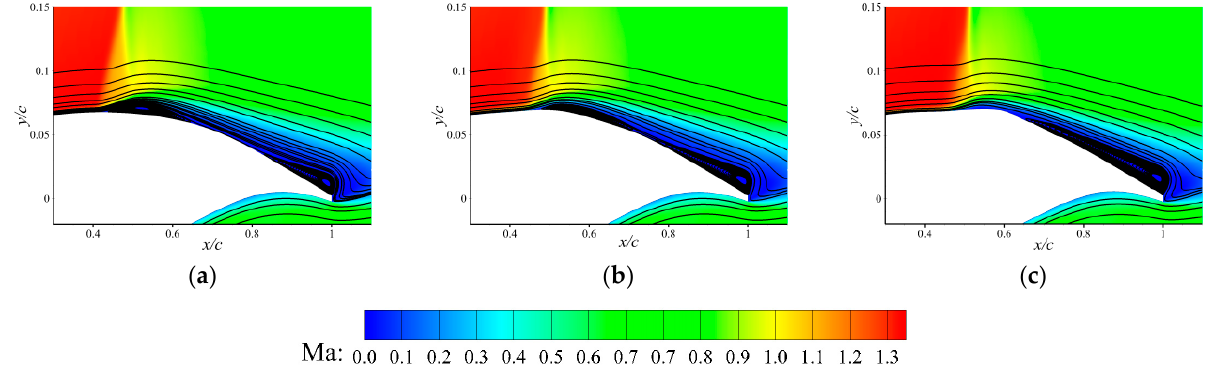
Figure 15. Mach number contours and streamlines in steady state for different configurations. ( a ) Original. ( b ) Bump 1. ( c ) Bump 2.